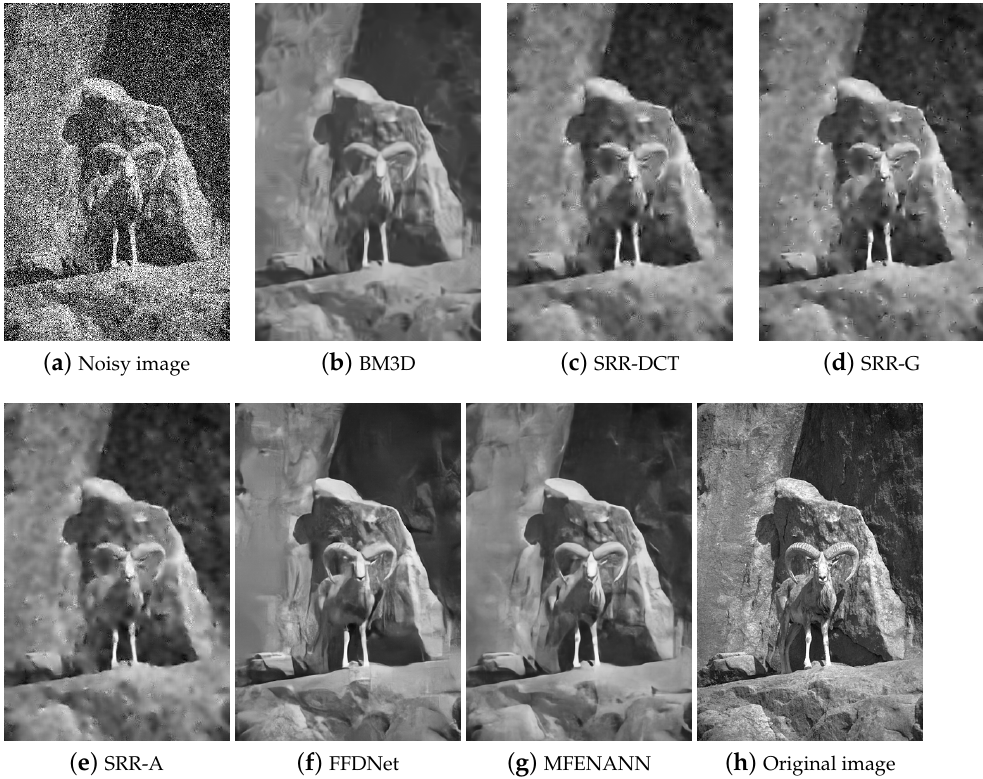
Figure 7. Experimental results of several state-of-the-art algorithms for image “test064” in “BSD68” at a noise level of 75.The PSNR values are: ( a ) noisy image, 10.63 dB; ( b ) BM3D, 22.11 dB; ( c ) SRR-DCT,